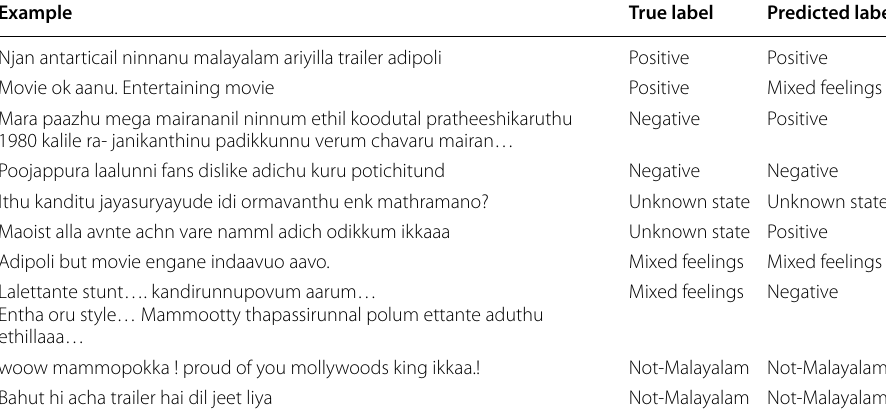
Table 12 Error analysis on predicted vs true labels for SA Example True label Predicted